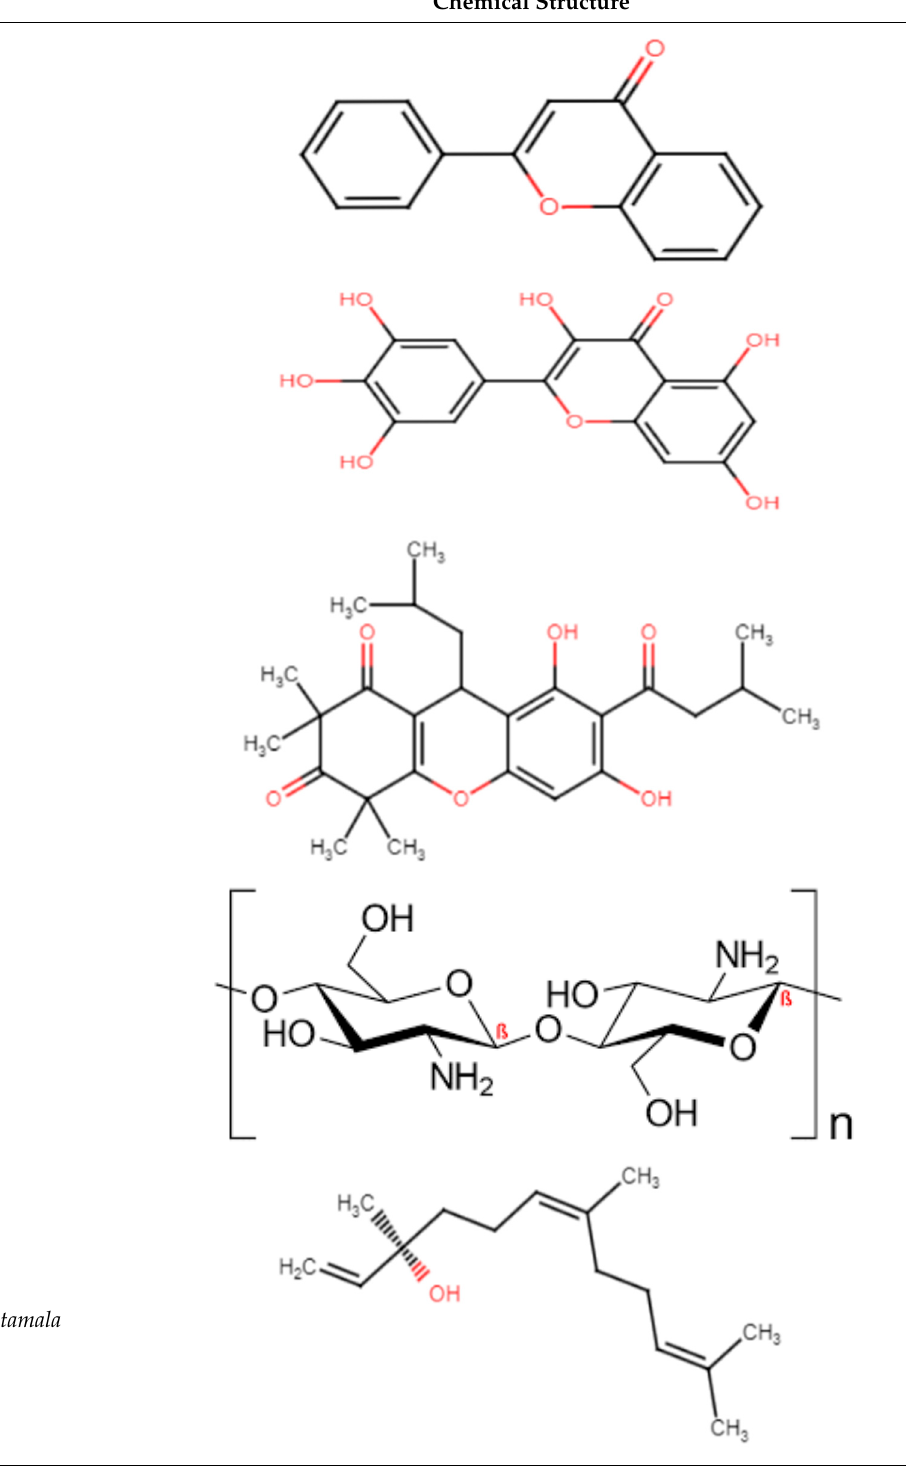
Table 1. Chemical structures of various staphyloxanthin inhibitors.